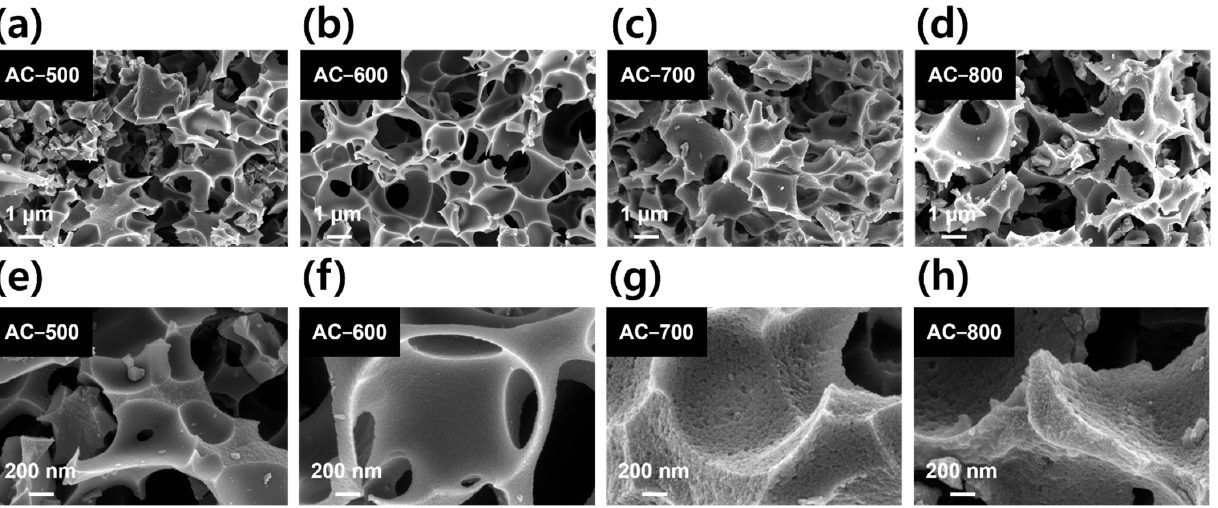
Figure 1. SEM images of the activated carbon (AC) samples prepared with coffee waste at different reaction temperatures from 500 to 800 °C. ( a ) AC-500 ; ( b ) AC-600 ; ( c ) AC-700 ; ( d ) AC-800 of low magnification SEM images ; ( e ) AC-500 ; ( f ) AC-600 ; ( g ) AC-700 ; ( h ) AC-800 of high magnification SEM images. Table 2. Comparison of specific surface areas and pore structures of the AC samples determined from the N 2